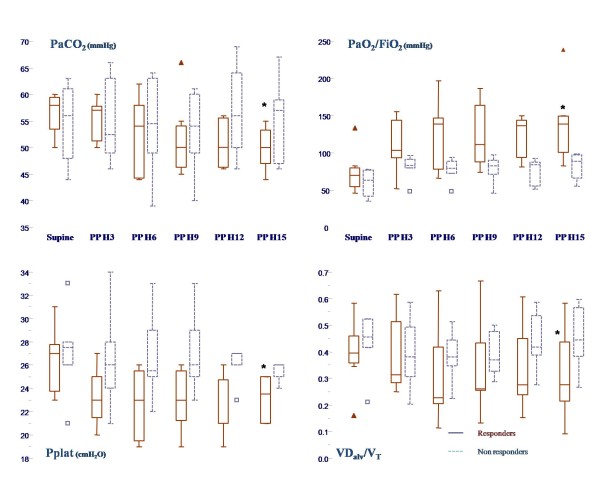
Alterations during PP in PaO2/FiO2, PaCO2, plateau pressure (Pplat) and alveolar dead space (VDalv/VT) in responders (solid lines) and nonresponders (dotted lines) according to PaCO2 changes. "PaCO2 responders" were defined by a decrease in PaCO2 > 2 mmHg after 15 hours of PP (PP H15). Shown are box and whisker plots. Median = horizontal line inside the box; upper and lower quartiles = whisker plot. Boxes and triangles represent values higher or lower than the upper or lower quartiles. *P < 0.05 for comparison of changes in responders versus nonresponders. PP: prone position.